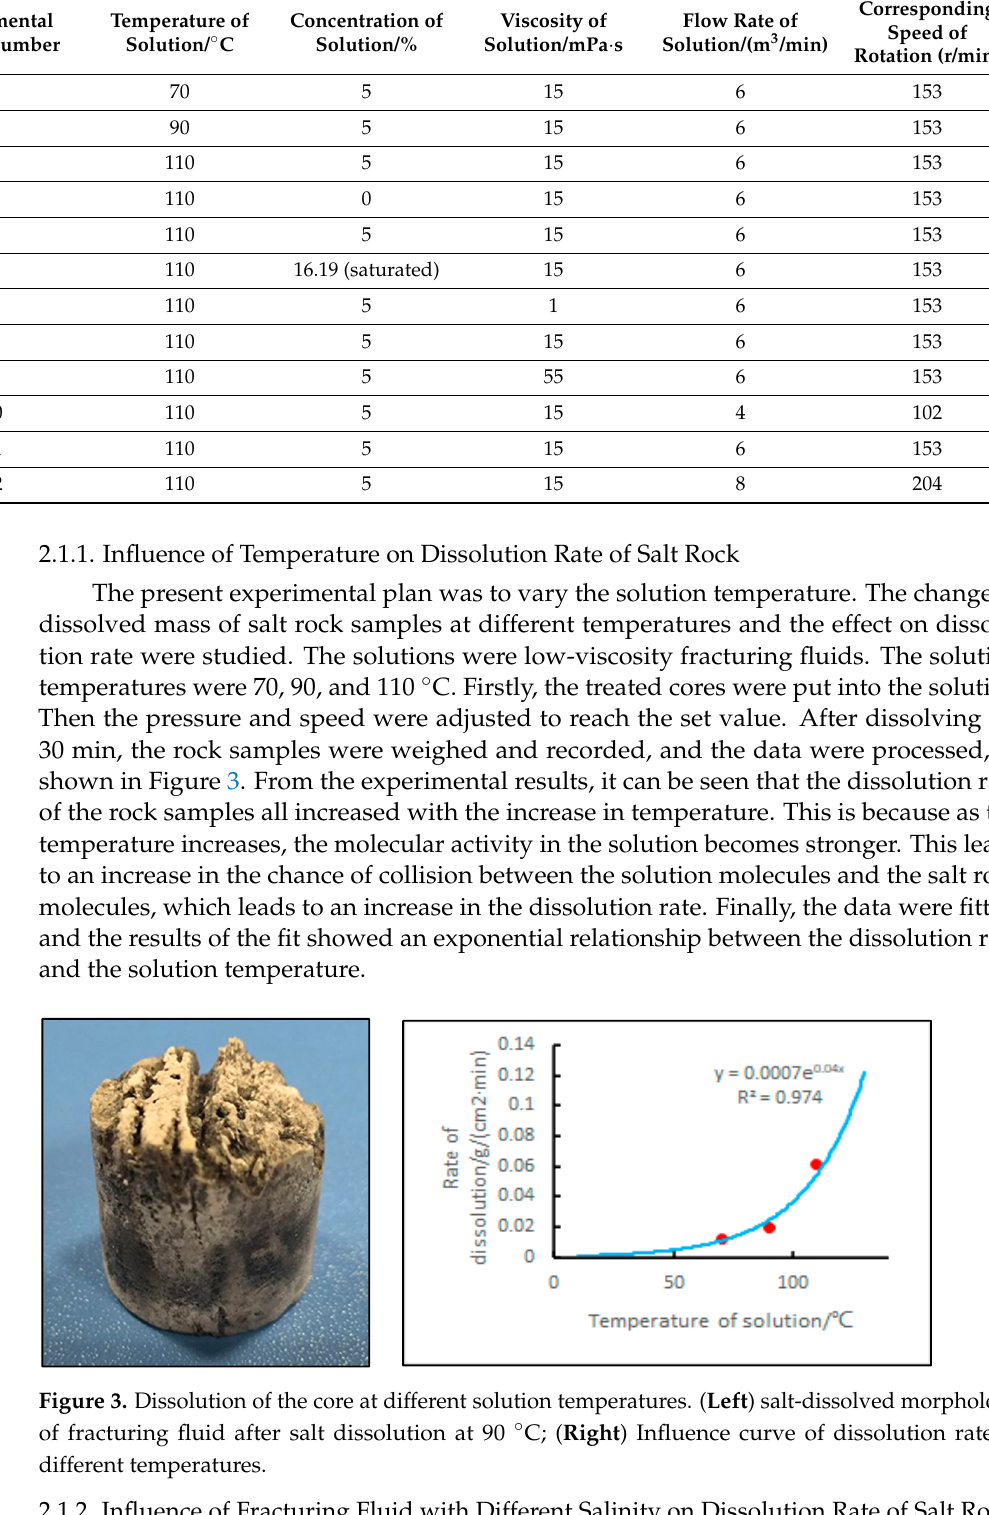
Table 2. Summary of the influences of various factors on dissolution rate.